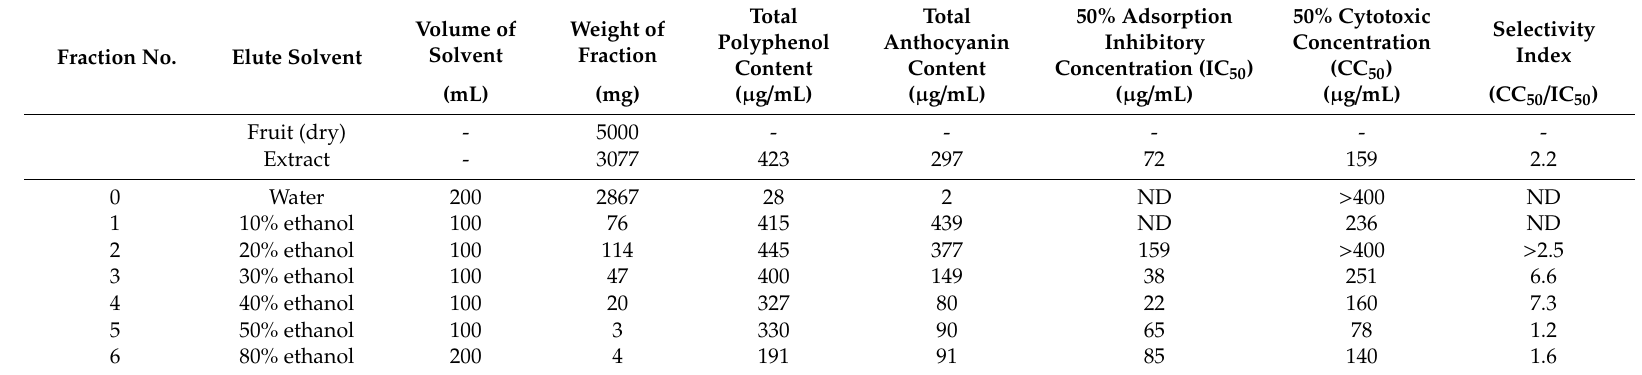
Table 1. Separation of Vaccinium oldhamii by synthetic